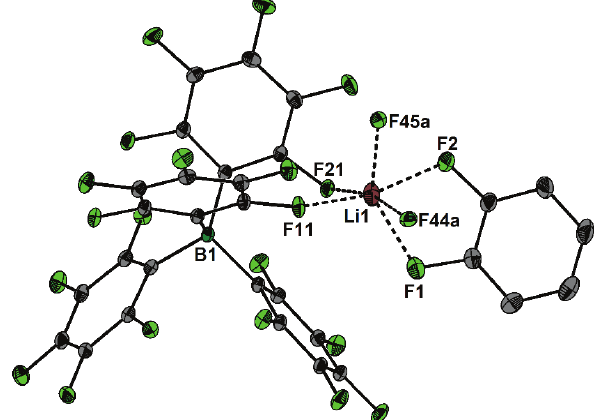
Figure 1: Crystal structure of [Li(1,2-F 50% probability ellipsoid and the essential atomic numbering.